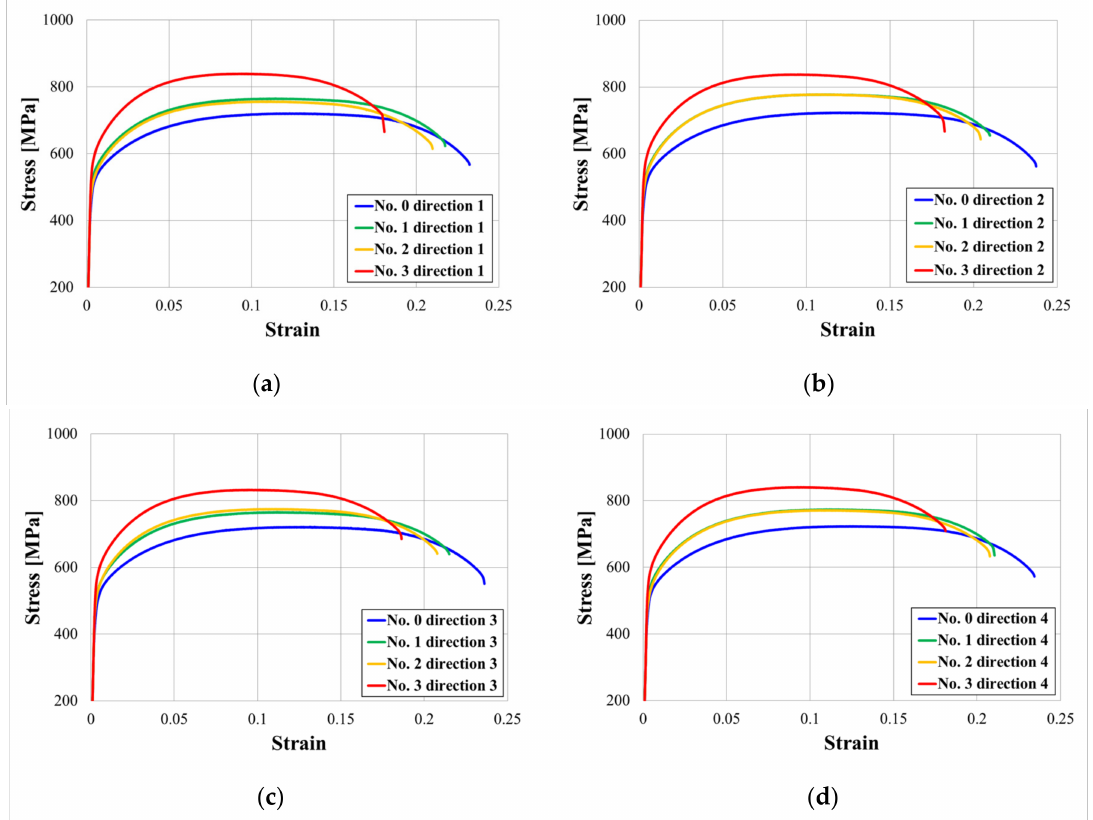
Figure 14. Tensile test results according to the circumferential direction in the four locations shown in Figure 4: ( a ) 1, ( b ) 2, ( c ) 3, and ( d )